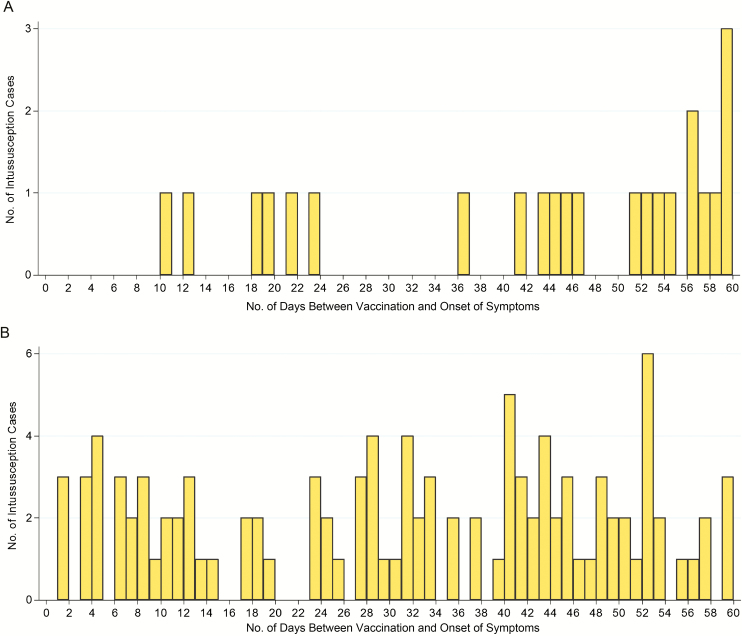
Cases of intussusception occurring during the first 60 days after dose 1 (A) and dose 2 (B) of rotavirus vaccine (Rotarix [RV1]). Three hundred thirteen intussusception cases occurred >60 days after dose 1; 183 cases occurred >60 days after dose 2.